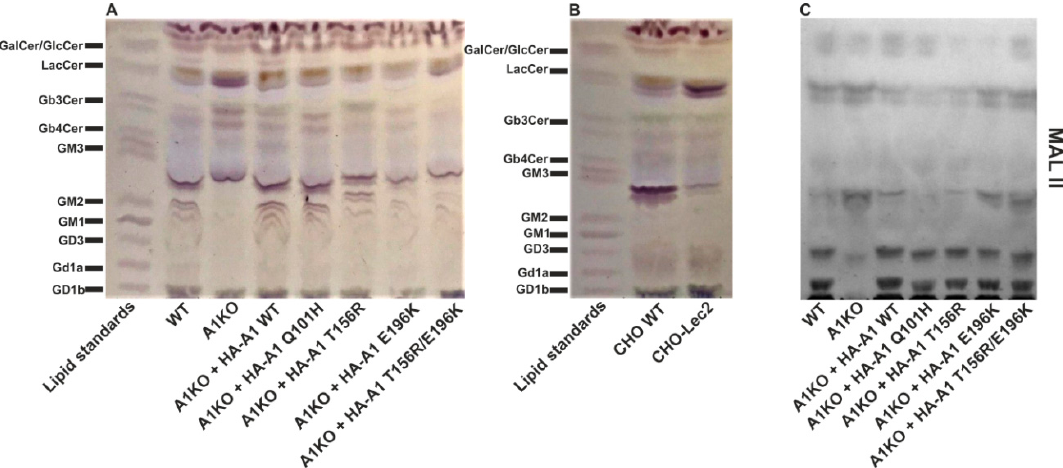
Figure 9. Analysis of glycolipids synthesized by HEK293T ( A ) and CHO ( B ) cell lines using orcinol assay. Total lipids were isolated from cells and separated using thin-layer chromatography, and glycolipids were specifically visualized with the orcinol reagent. A mixture of different standard glycolipids was resolved in parallel. ( C ) Detection of sialylated glycolipids produced by HEK293T cell lines using Maackia amurensis lectin II (MAL II). A1, SLC35A1.